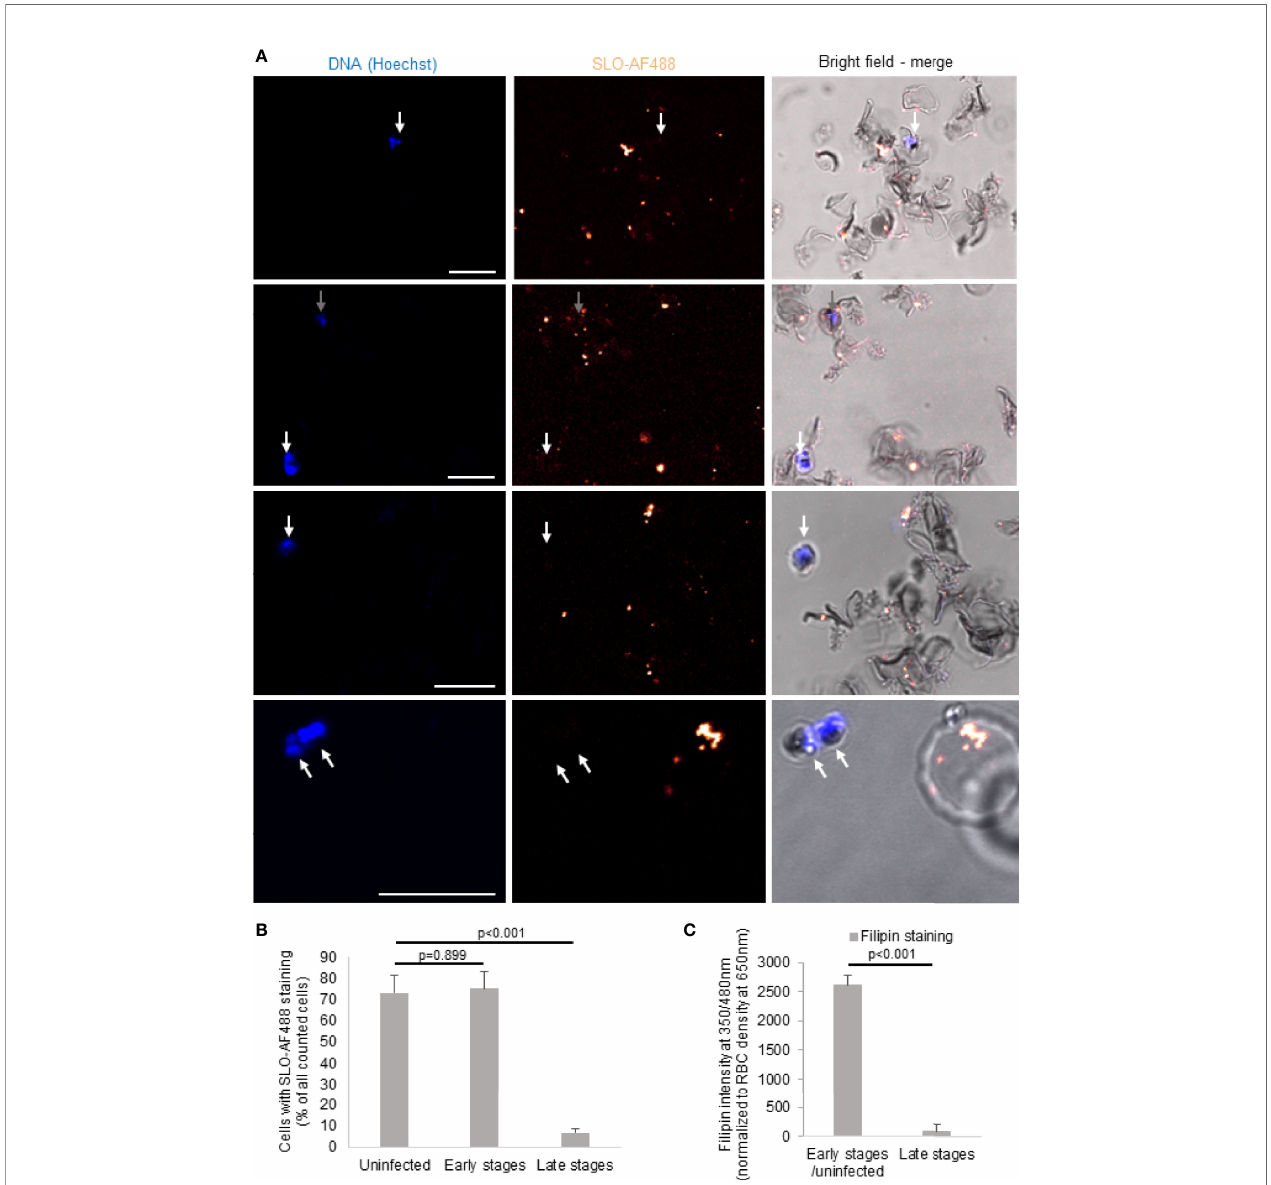
FIGURE 2 | Cholesterol is depleted of late-stage iRBCs. Non-synchronized iRBCs were treated with Alexa Fluor 488-labeled streptolysin O (SLO-AF488; 2 U/ m l) for 60 minutes on ice before fi xation and assessment by confocal microscopy. Nuclei were stained with Hoechst. Scale bars are 10 m m. Four representative images from three independent experiments are shown in (A) . The white arrows indicate the late stage iRBC (not stained with the SLO-AF488) and the gray arrows show the early stage iRBC (stained with the SLO-AF488). The quanti fi cation (n>40 for each stage form in every independent experiment) of the three independent experiments is presented in (B) . (C) iRBCs were MACS puri fi ed to enrich for late stages before fi lipin staining and fl uorescence measurement by plate reader and compared to MACS fl ow-through cells (early stages and uninfected). Averages +/- SEM of three independent experiments are shown. P values of differences, calculated by Student`s t test, are